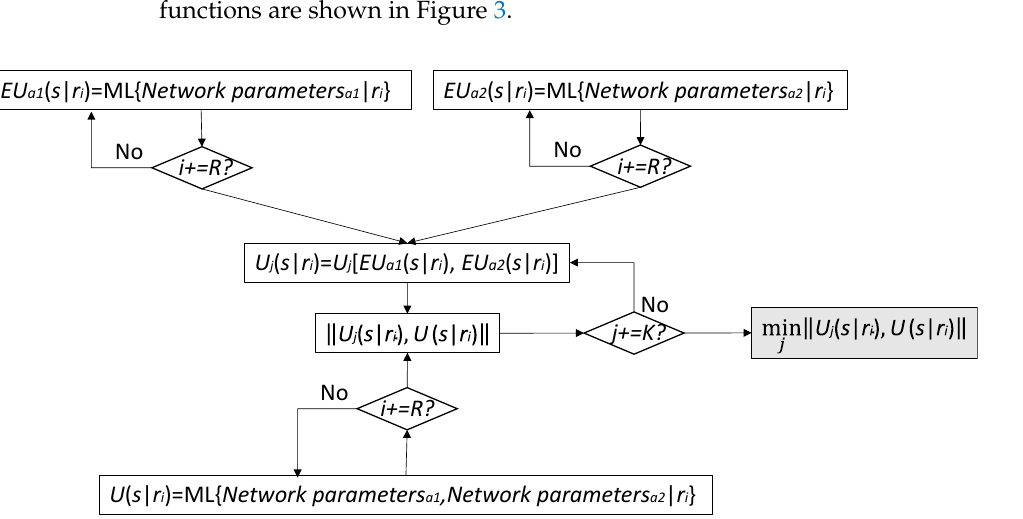
Figure 3. Machine Learning (ML)-based methodology for achieving final Utility functions used in two-steps routing selection.